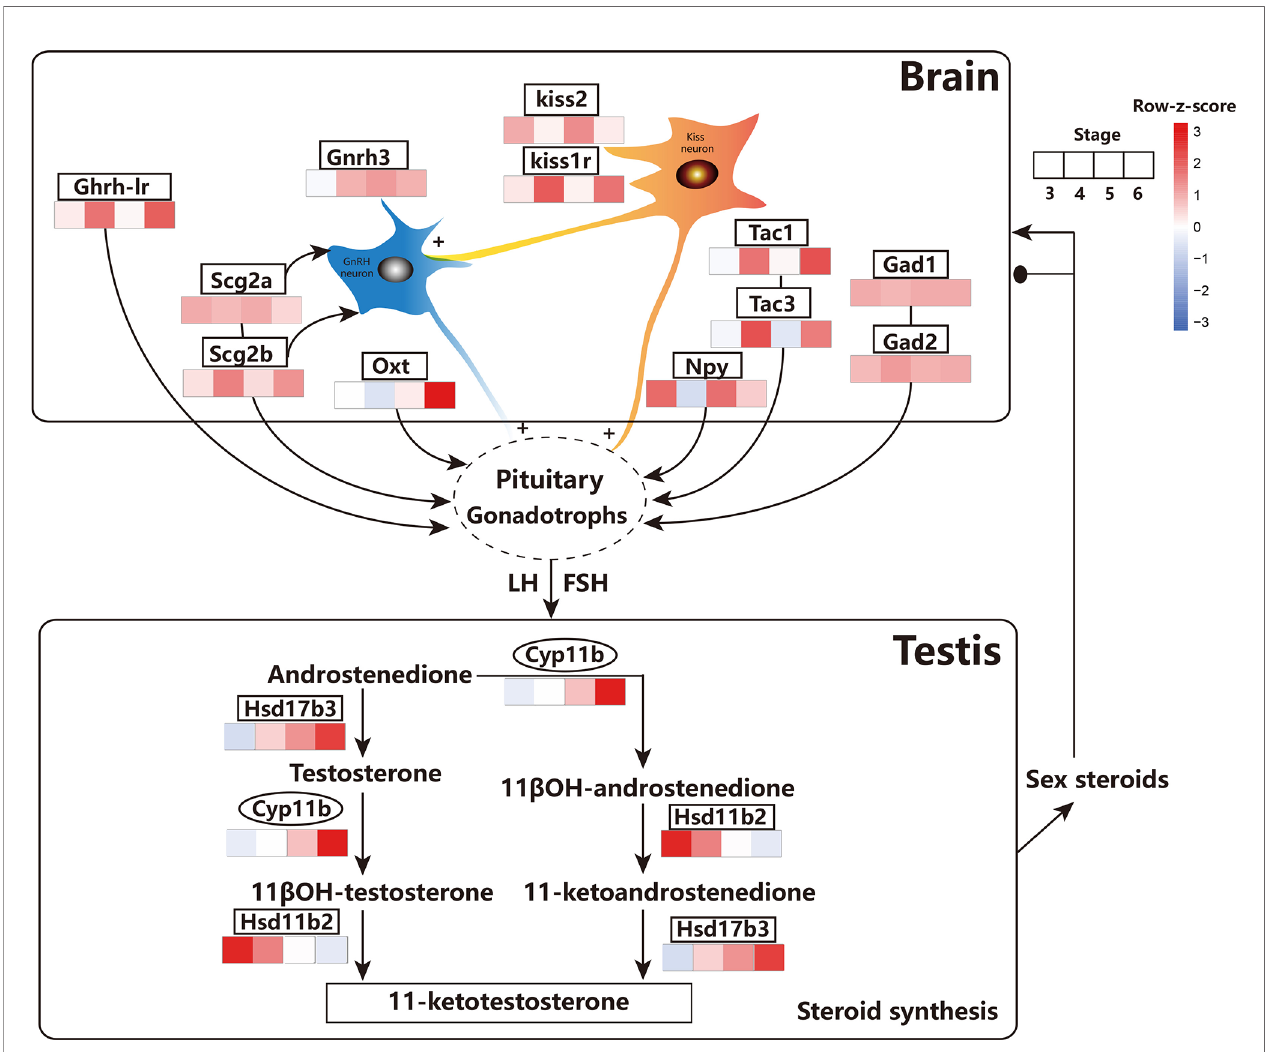
FIGURE 9 | Schematic diagram showing the main events related to the testis and brain involved in the HPG axis across testicular differentiation and maturation inferring from the results of this study. GnRH3, Gonadotropin-releasing hormone; Kiss2, Kisspeptin2; Kiss1r, Kisspeptin1r; GHRH-LR, pituitary adenylate cyclase- activating polypeptide type I receptor-like; SCG2a/b, Secretoneurin II a/b; OXT, isotocin; GAD1/2, g -aminobutyric acid; NPY, neuropeptide Y; TAC1/3, Tachykinin 1/ 3; Cyp11b, Cytochrome P450 family 11 subfamily B polypeptide; Hsd17b2, Hydroxysteroid 17-Beta dehydrogenase B2; Hsd17b3, Hydroxysteroid 17-Beta dehydrogenase B3. FSH, follicle-stimulating hormone; LH, luteinizing hormone. the transcription factor. The expression values were represented by FPKM/z-score. Ovals represent the transcription factors. The GnRH in the brain stimulates the secretion of pituitary gonadotropins, FSH, and LH, which in-turn act on the testes to stimulate the production of sex steroid